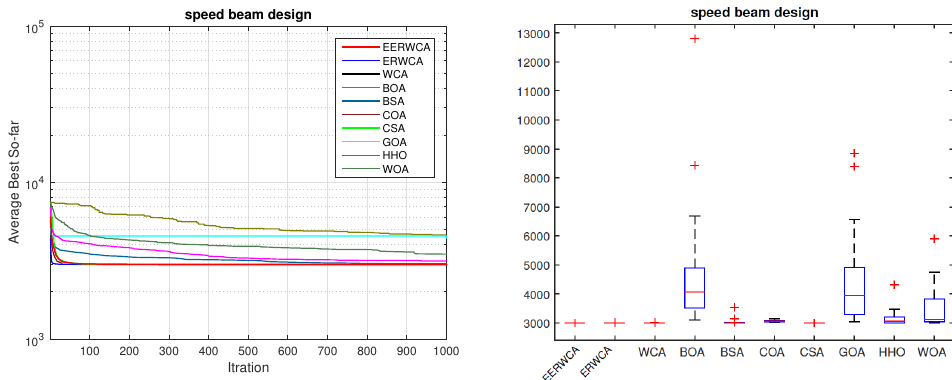
Figure 7. Design of Speed Reducer. Table 7. Statistical results of EErWCA versus other metaheuristics on speed reducer